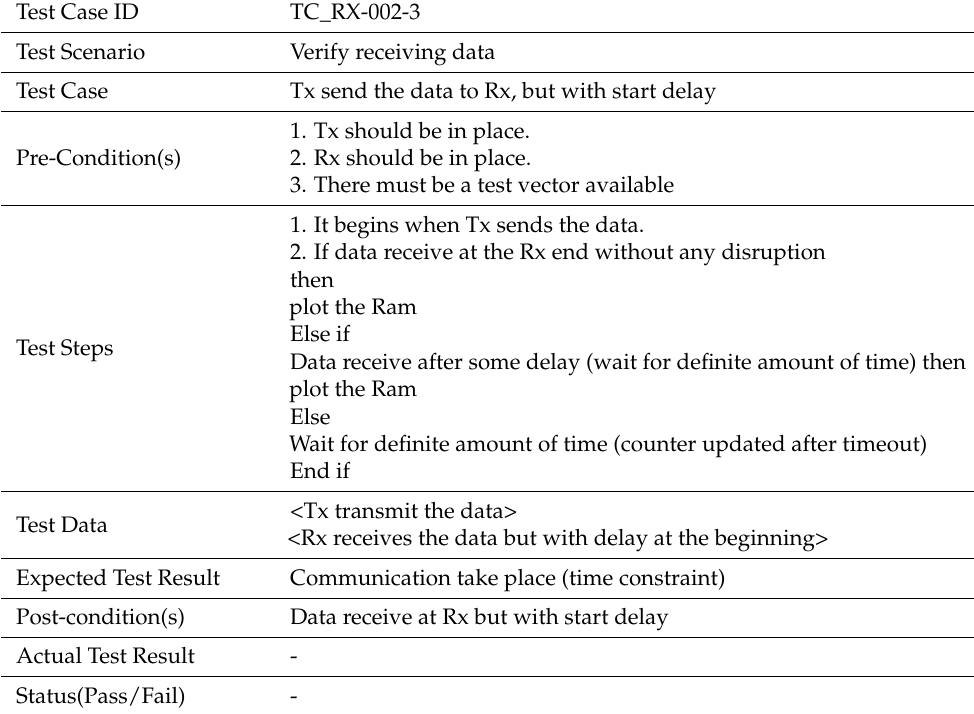
Table 3. Test case for “Rx”- data received at Rx with start